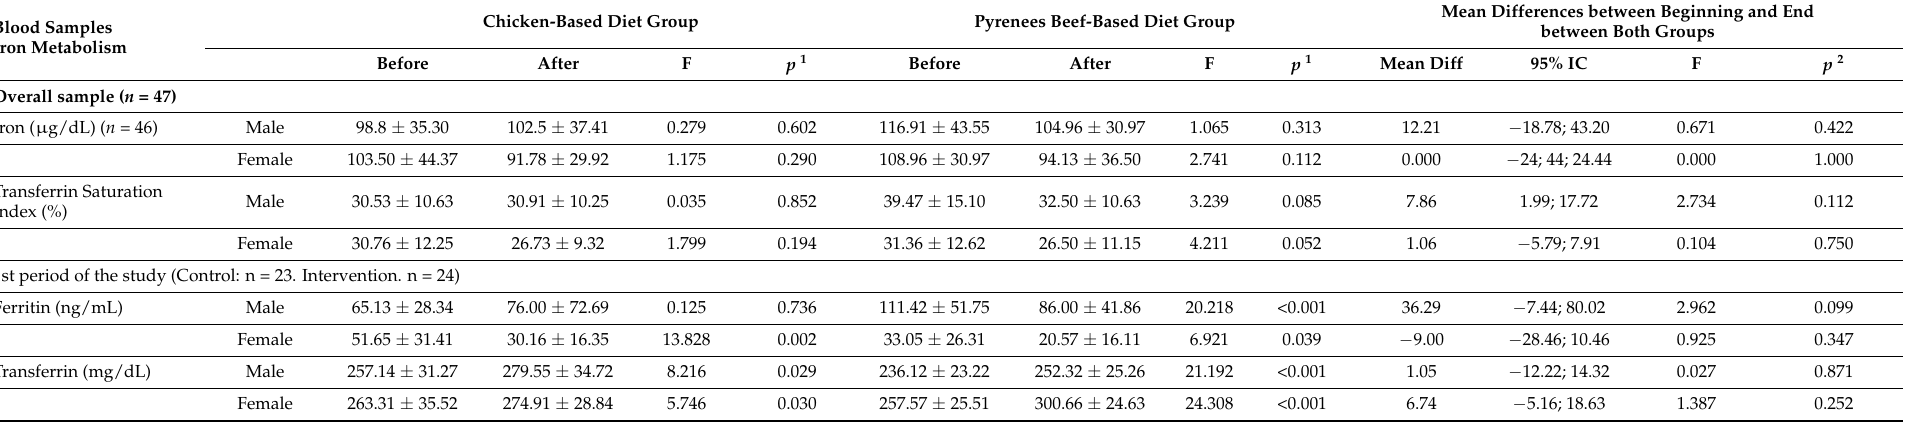
Table 5. Mean values of iron metabolism between both chicken and Pyrenees’ beef diet’s groups by gender, in the overall sample, and in the first period of the